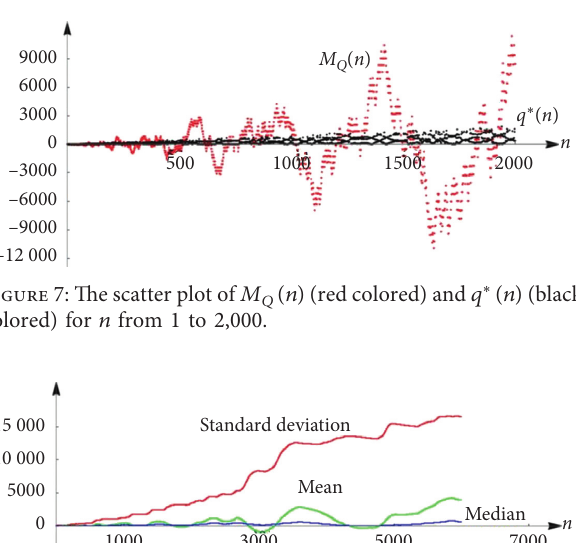
Figure 8: Standard deviation, mean, and median of M